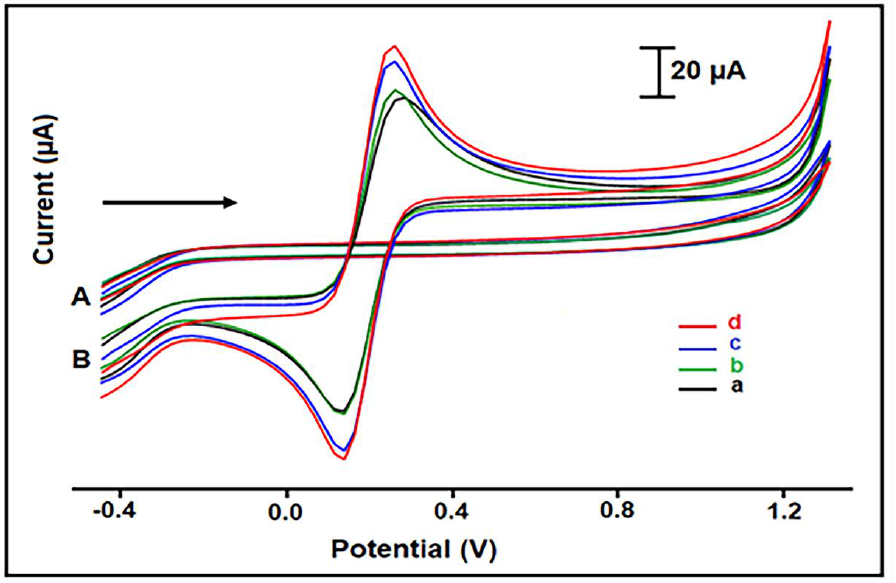
Figure 2 Figure 2. CVs obtained by ( a ) PGE, ( b ) HaP-PGE, ( c ) IL-PGE, and ( d ) HaP-IL-PGE.